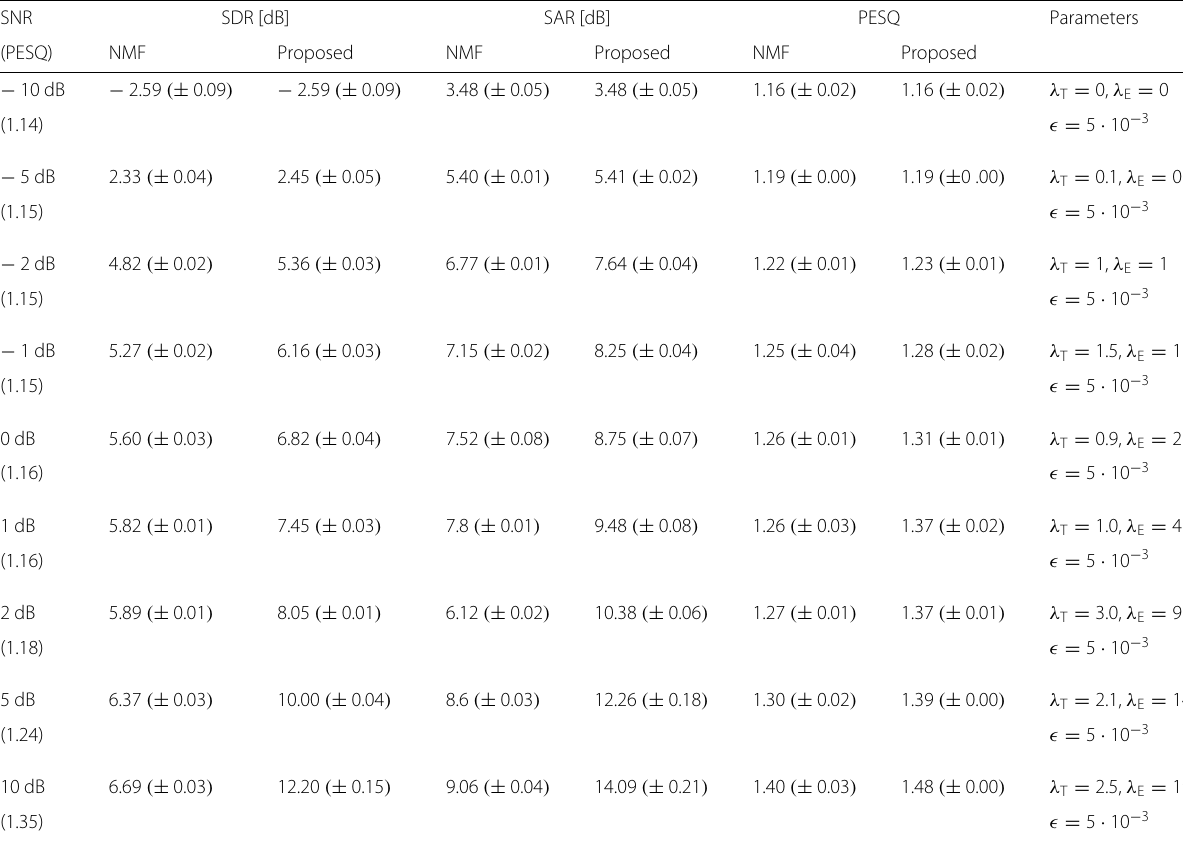
Table 3 Suppression performance achieved by NMF and the proposed method for varying SNRs. For this experiment, ego-noise by movements of Sequence II is used. Parameters used for proposed methods are given in the last rows. For all SNRs, dictionaries of size K = 30, K S = 20 are